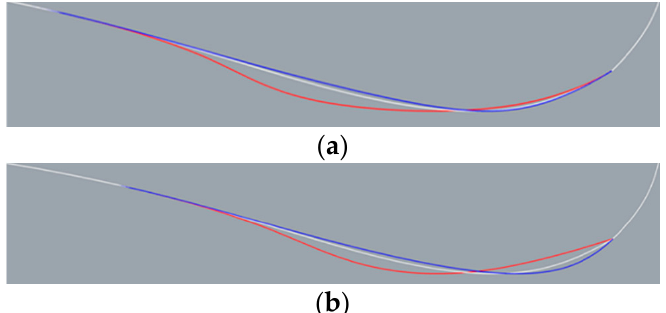
Figure 5. Step (1) result : 𝜃 = 14.113 ° (red line), 14.967 (white line), and 18.718° (blue line). ( a ) Type A and ( b ) Type B.